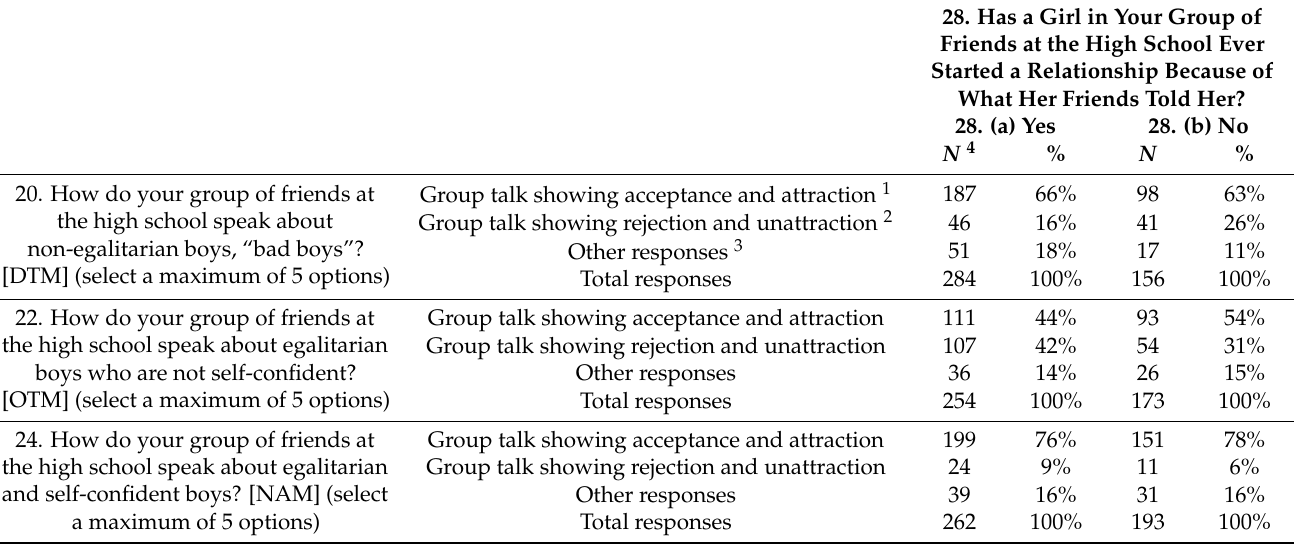
Table 2. Peer group talk about types of masculinity and peer group pressure on